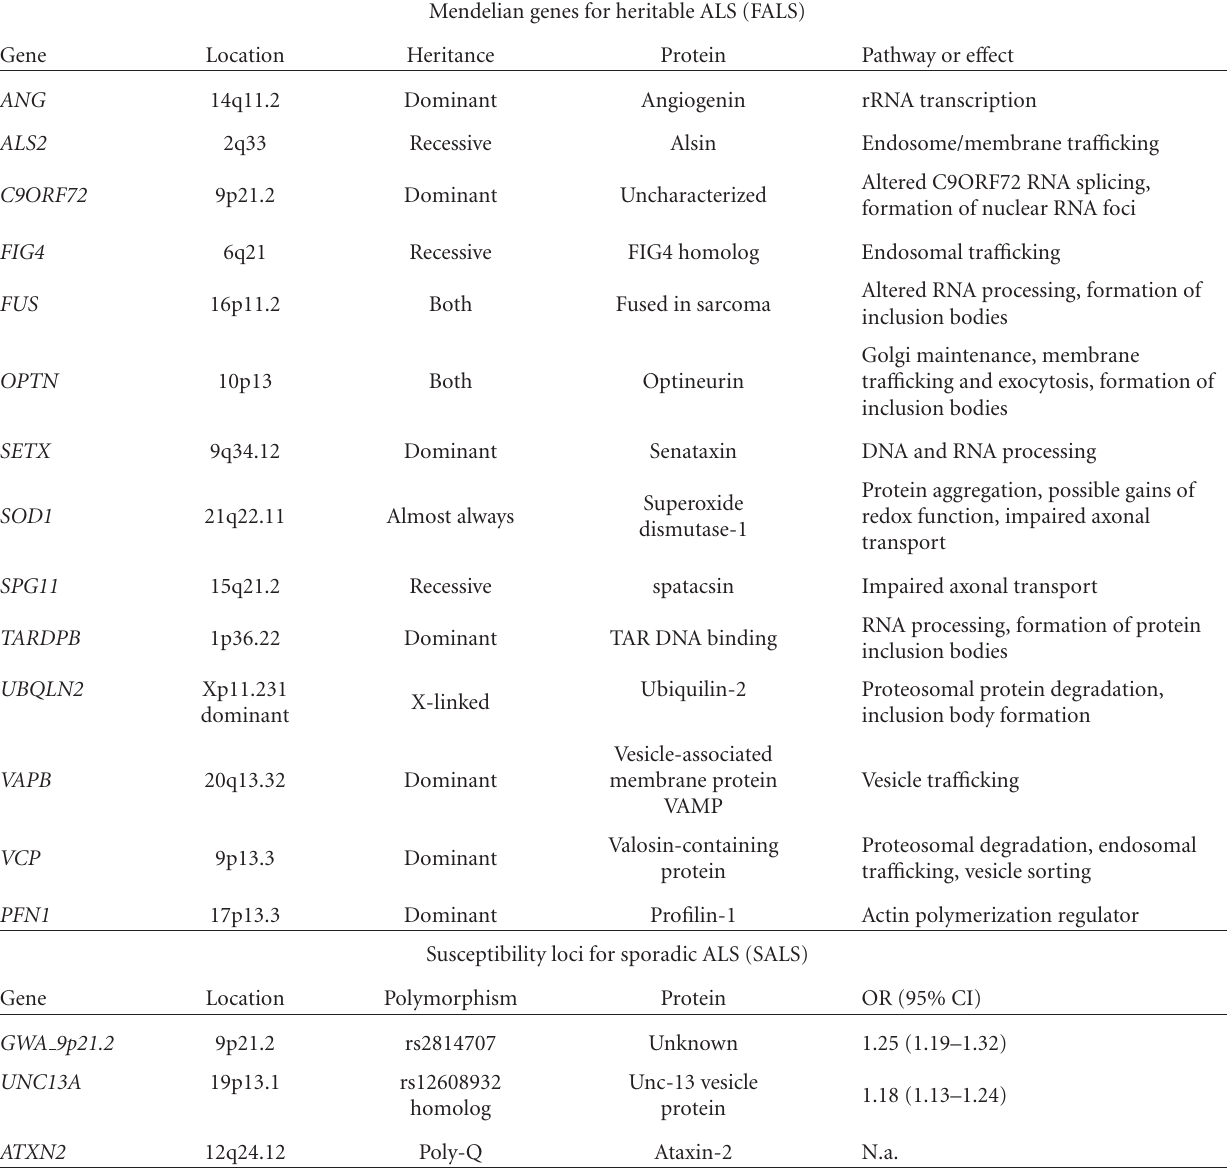
Table 1: Mendelian and non-Mendelian loci known to cause FALS or confer risk for SALS. Information in this table reproduces content in Tables 7 and 8 from Lill and Bertram, 2011 ([2], and databases therein). Polymorphisms in the VEGF promoter that were originally associated with increased ALS risk have not been confirmed in subsequent studies but may act as modifiers of disease onset or progression in subsets of ALS cases